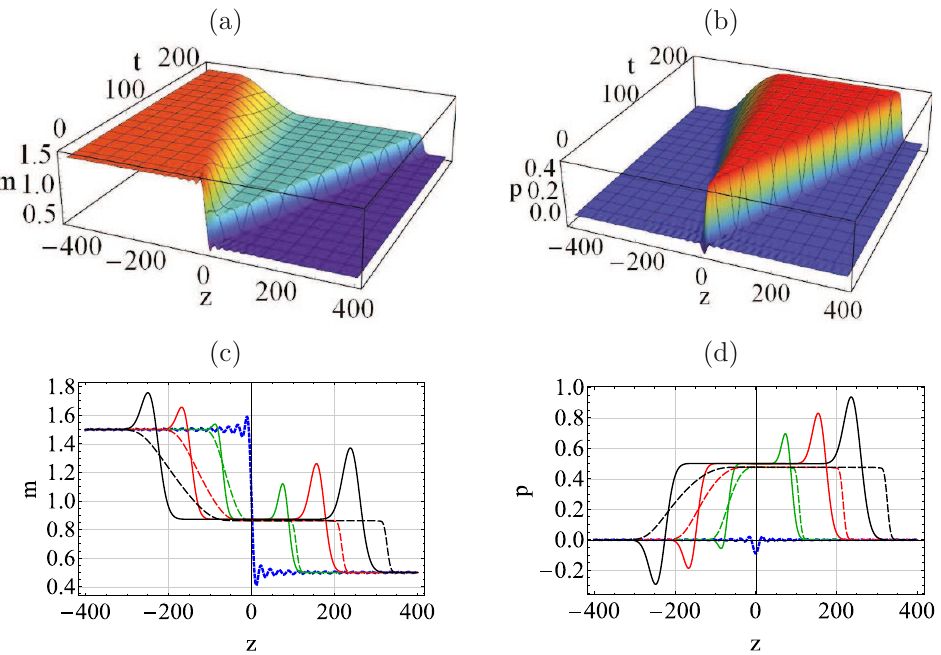
Figure 6 . Three-dimensional plots of full-order numerical solution (a) m ( t, z ) and (b) p ( t, z ), obtained by solving eqs. (2.1) and (3.1) with initial condition eq. (3.15) where sgn( z ) is replaced by finite Fourier series of sgn L ( z ) given by eqs. (3.31)–(3.33). The comparison between second-order solution (c) 1 + m 1 ( t, z ) + m 2 ( t, z ) (resp. (d) p 1 ( t, z ) + p 2 ( t, z )) and full-order numerical solution m ( t, z ) (resp. p ( t, z )), obtained by solving eqs. (2.1) and (3.1). The blue-dashed curve represents initial configuration m (0 , z ) (resp. p (0 , z )). The green, red, and black solid curves represent the second-order solutions at t = 83 . 3, 167, and 250, respectively. The (green, red, and black) dashed curve represents the full numerical solution at the corresponding